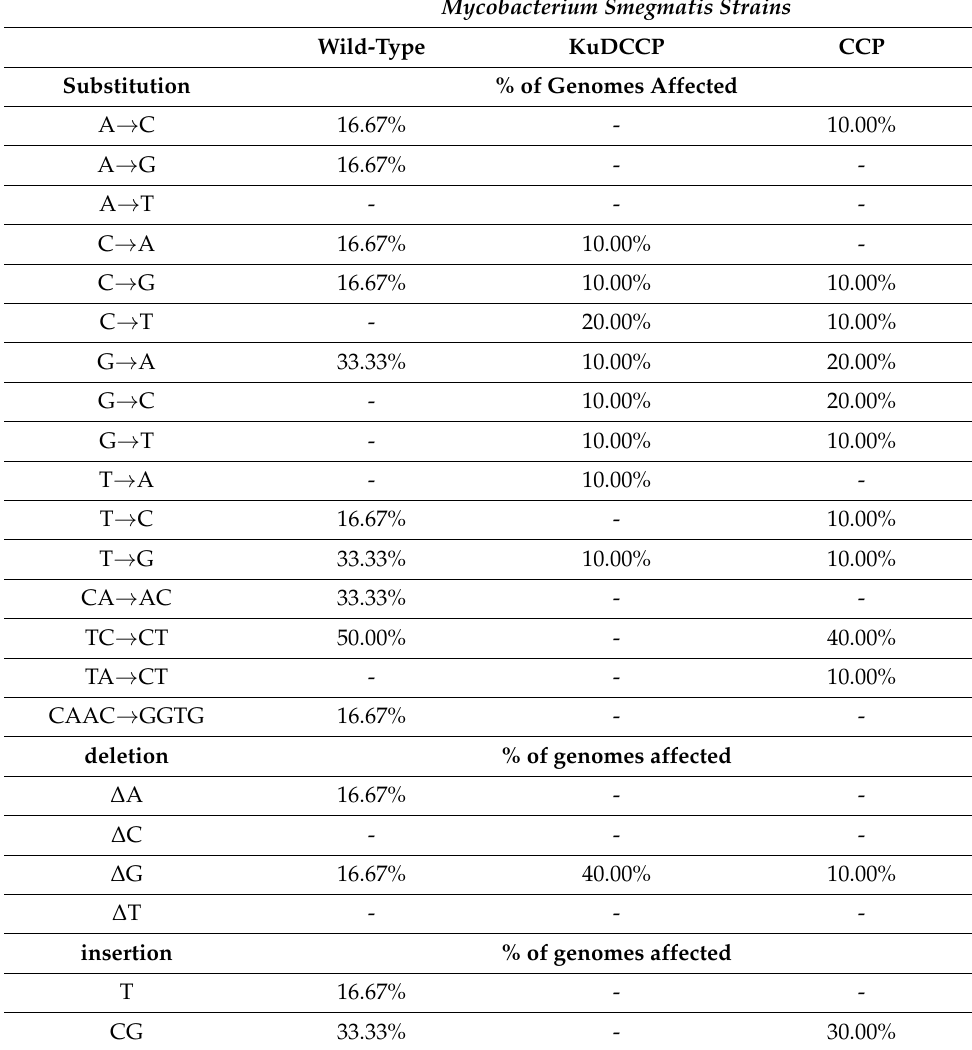
Table 1. Mutations detected in the individual colonies of Mycobacterium ( Mycolicibacterium ) smegmatis cells growing in the presence of cumene hydroperoxide